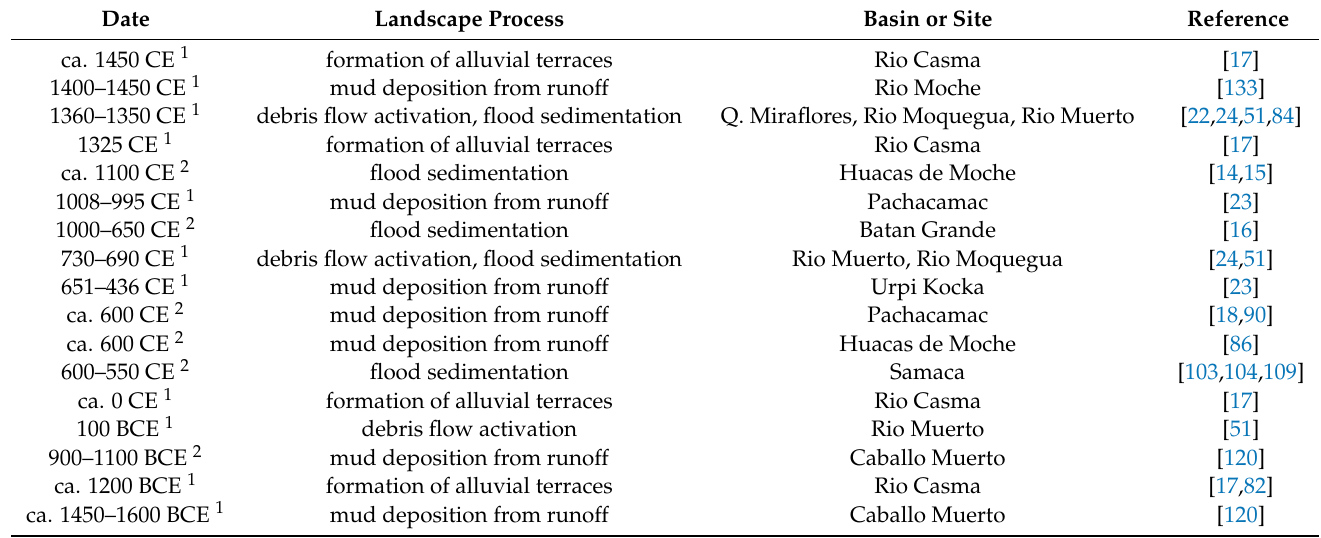
Table 5. Chronology of late pre-Hispanic El Niño events argued as possibly responsible for land- scape